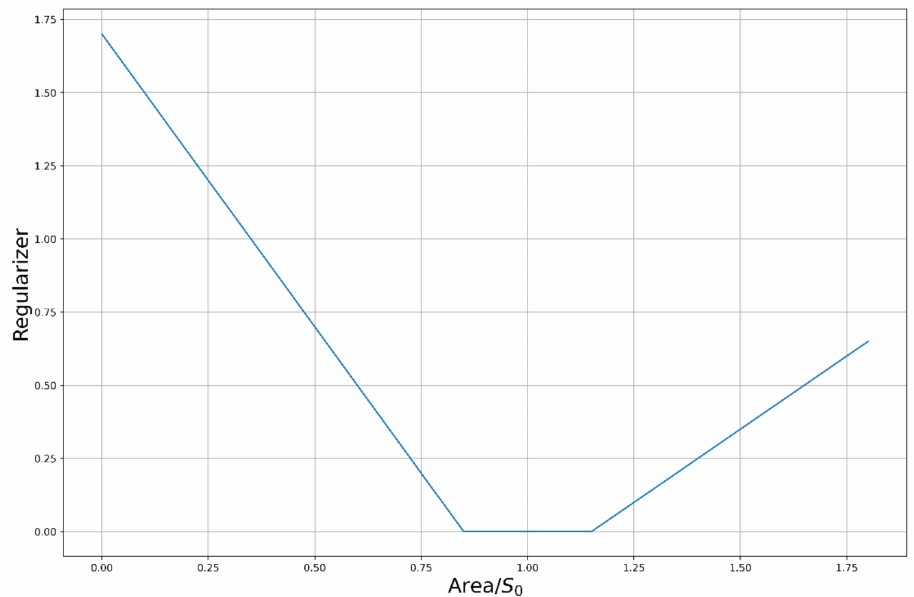
Figure 1. Regularizer function dependence on area of current-voltage (I-V)